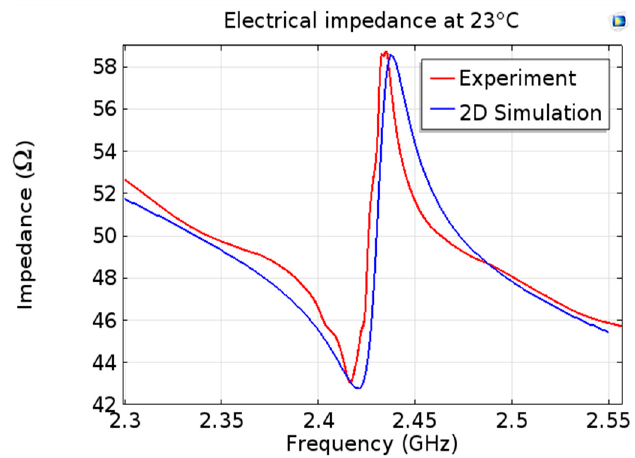
Figure 4. Comparison of the simulated and experimental impedance moduli at 23 °C.